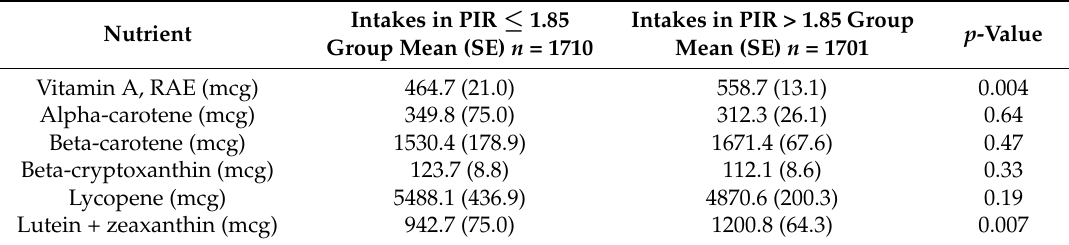
Table 3. Intake of vitamin A and carotenoids by PIR group.